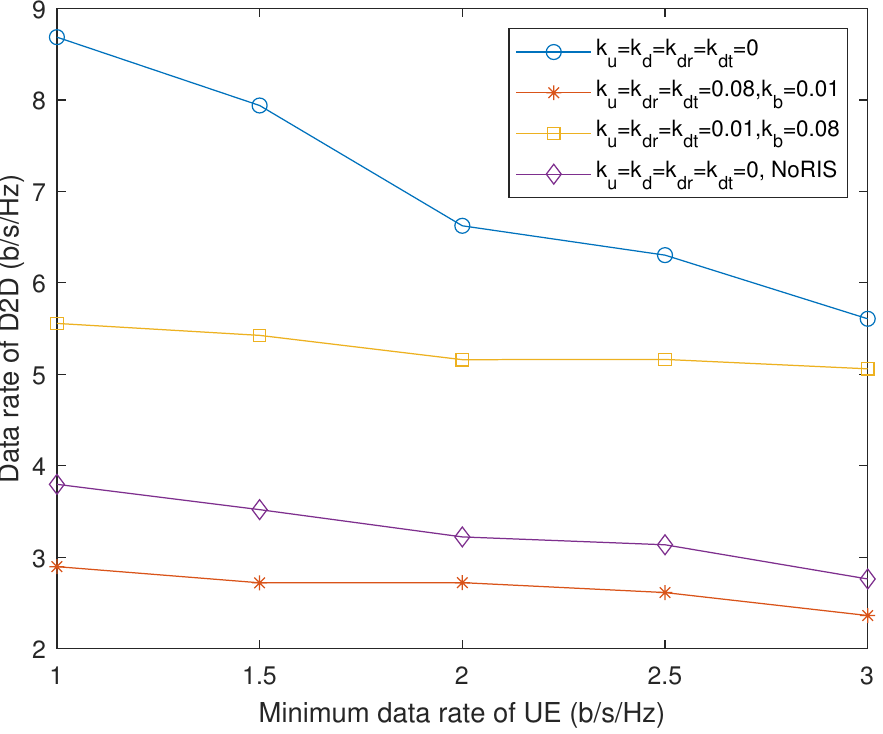
Figure 4. Minimum data rate of UE versus the data rate of